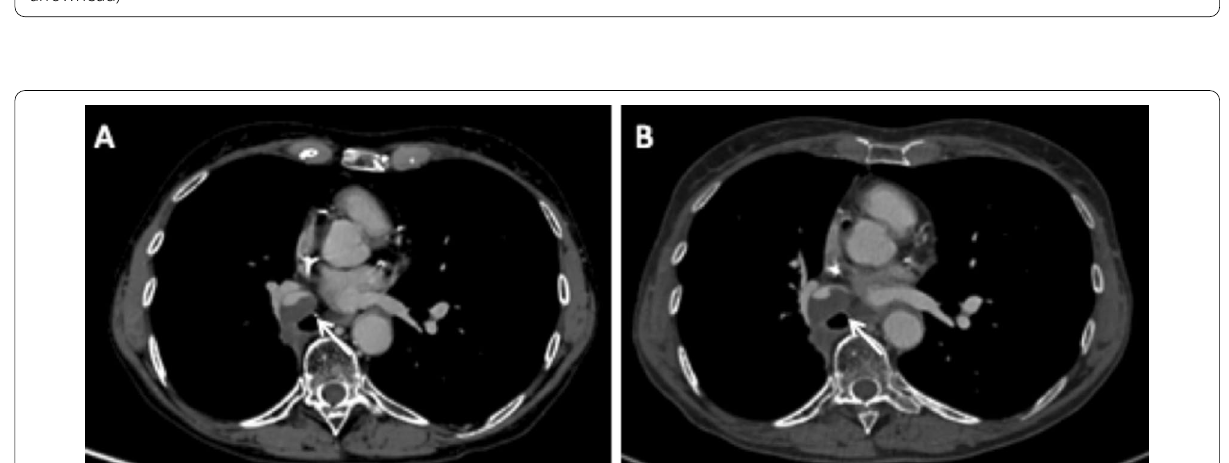
Fig. 14 Progressive alluvial thrombus. Axial CT images (mediastinal window) in May 2019 ( A ) and November 2019 ( B ), showing an evolutive alluvial thrombus in the interlobar artery stump, respectively, 6 months and 11 months after right lower and middle